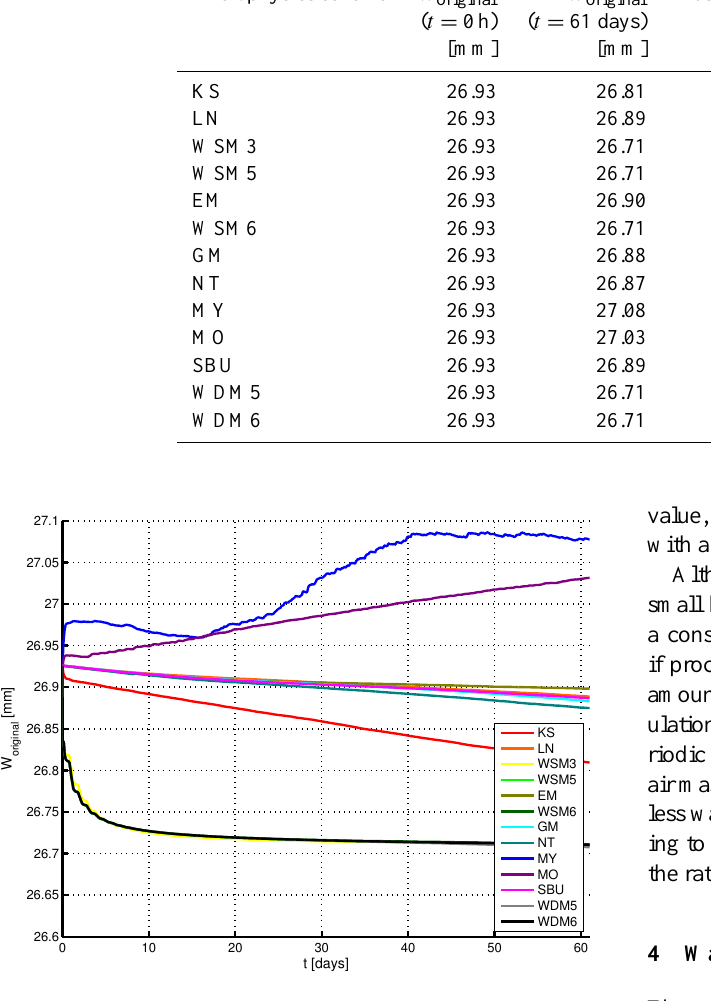
Fig. 3. The original total water mean column density evolution in time for the 13 microphysical schemes. At the beginning of the sim- ulation W original = 26 . 93mm for all the schemes and then it evolves independently, based on each scheme’s microphysical transforma- tions which cause small gains and losses of water during the tran- sitions from one water species/phase into another. The correspon- dence between the abbreviations in the legend and the names of the schemes can be found in Table